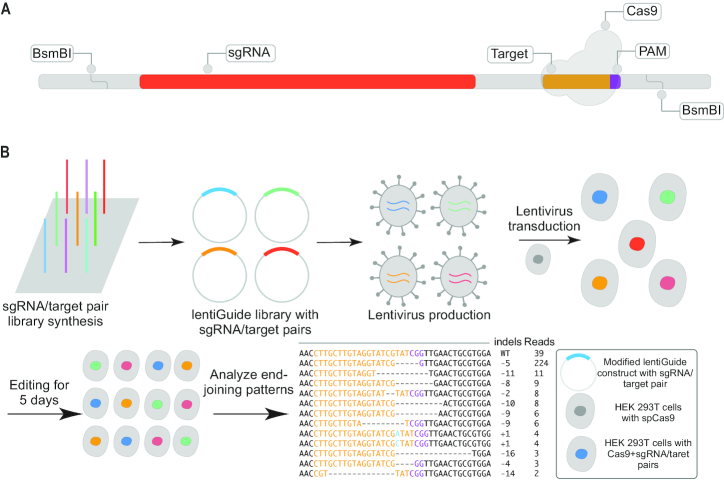
An assay for massively parallel profiling of the outcomes of CRISPR/Cas9-mediated double-stranded DNA break repair. (A) Schematic of library of 200 bp oligonucleotides encoding sgRNAs (red) targeting a large number of designed 20 bp spacers, with their matched target sequence encoded in cis (yellow: target; PAM: purple). In our primary experiment, 70 000 target sequences were designed and cloned. (B) After array-based synthesis and PCR amplification of the library, BsmBI restriction sites at either end were used for cloning into a modified lentiviral construct. The library was bottlenecked to 12,286 targets to facilitate greater coverage of independent NHEJ-mediated events corresponding to each target. Monoclonal HEK293T cells expressing Cas9 were transduced with packaged lentivirus. Cells were harvested at 5 days after transduction, and a region including both the spacer and the target was PCR amplified from genomic DNA for high-throughput sequencing. The sequences of mutated targets were aligned to their corresponding unmutated reference, assigned based on the spacer sequence (yellow: target; PAM: purple; green: inserted bases; dashes: deleted bases).